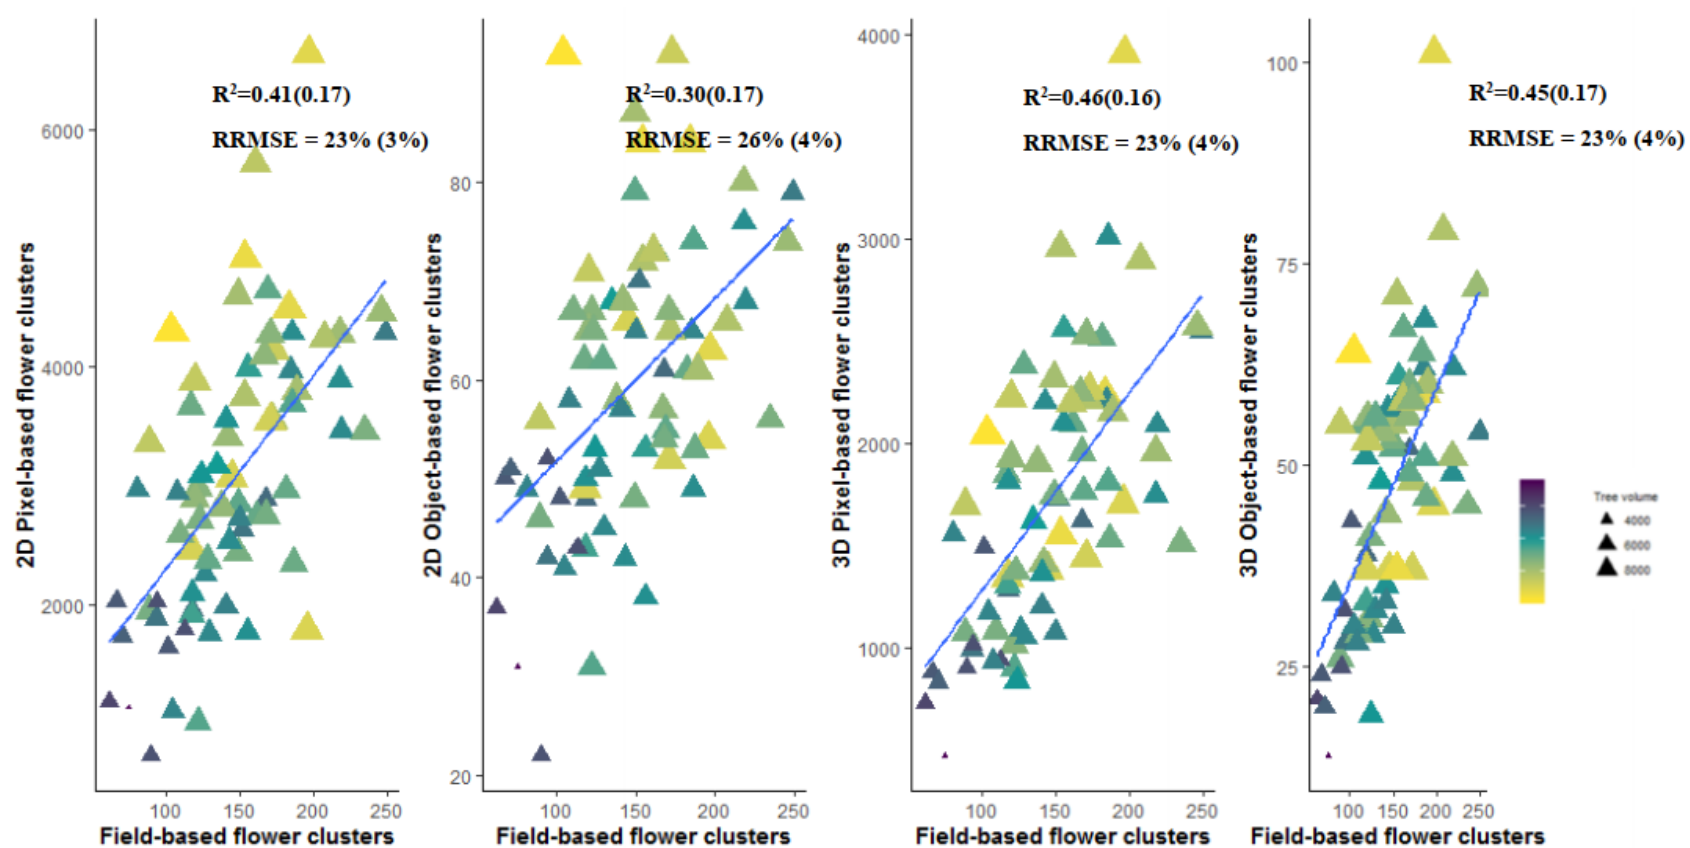
Figure A2. Correlation plots of Wimmertingen between the field-based flower clusters and the four retrieval models (i.e., 2D pixel-based flower clusters, 2D object-based flower clusters, 3D pixel-based flower clusters and 3D object-based flower clusters); the tree volume in cm 3 is visualized by the symbol size and color of the datapoints.